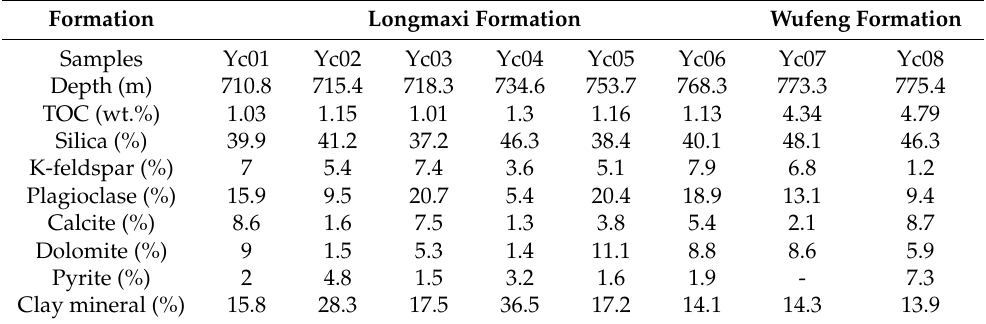
Table 1. TOC contents and basic mineral composition data for shales from the WF-LMX Formation.